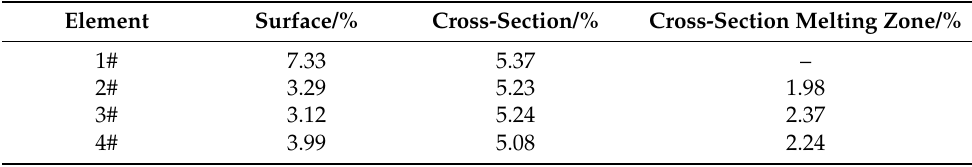
Figure 6. The cross section micro-morphology of CS FAA coatings re-melted by lasers with different Table 3. Porosity of the CS and laser re-melted CS FAA coatings.